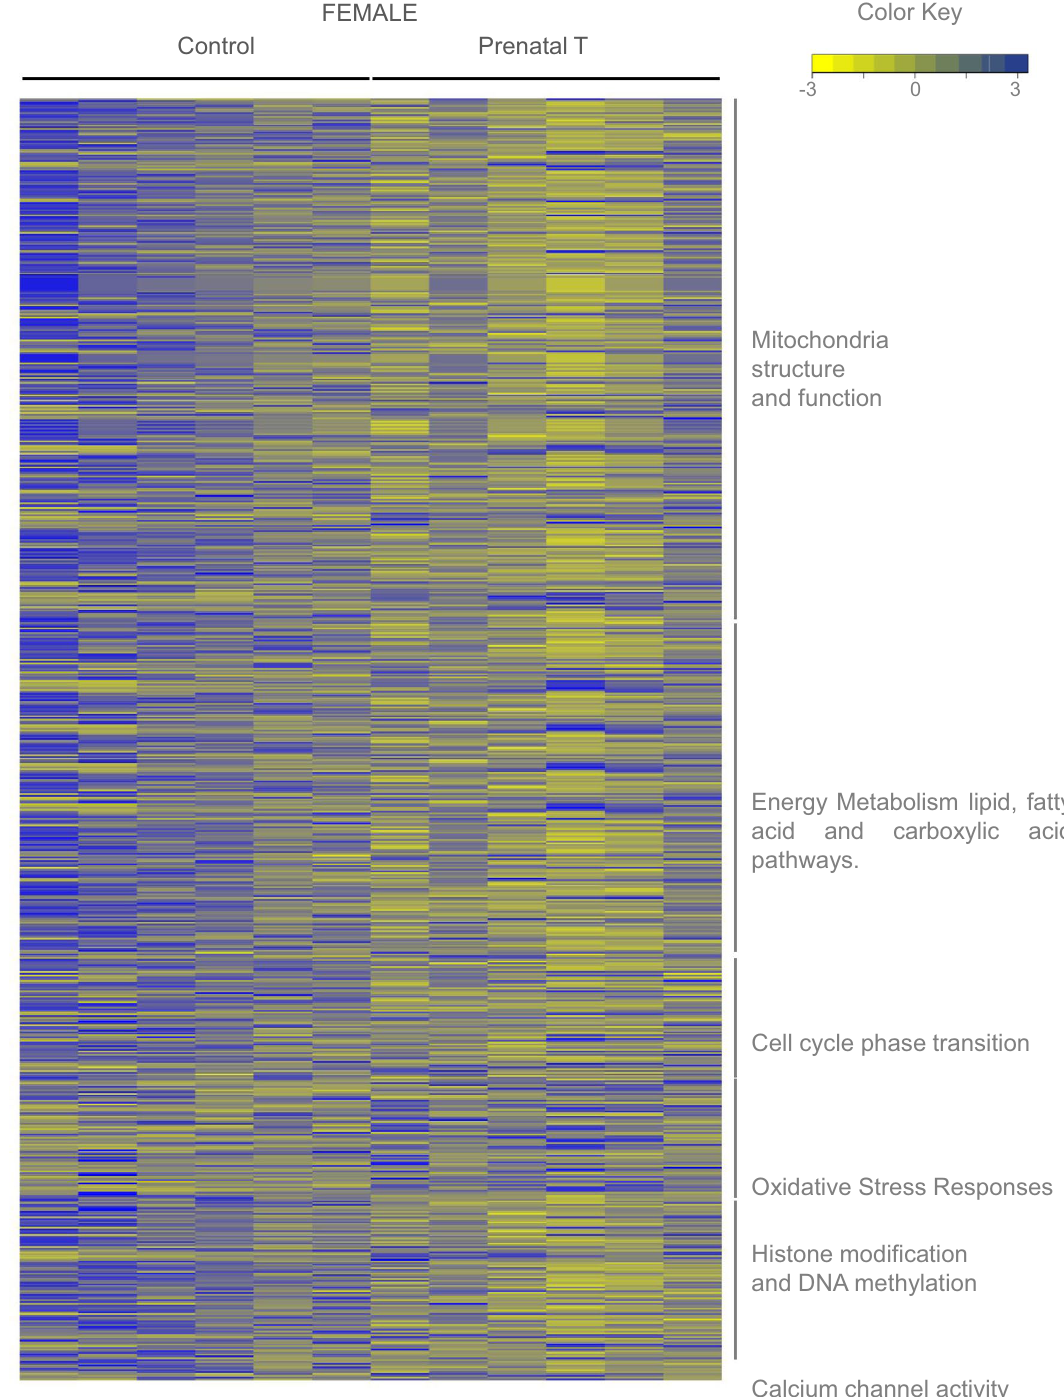
Figure 5. Expression Levels of Genes in Dysregulated Pathways Unique to Female Fetal Cardiac Tissue in Response to prenatal T. Heatmap showing genes involved in the pathways representing selected pathways that is dysregulated uniquely in female (C = 6, T = 6). The genes associated with the gene pathway in controls animals and prenatal-T treated animals are plotted along a gradient of colors, with blue representing highest and yellow the lowest normalized